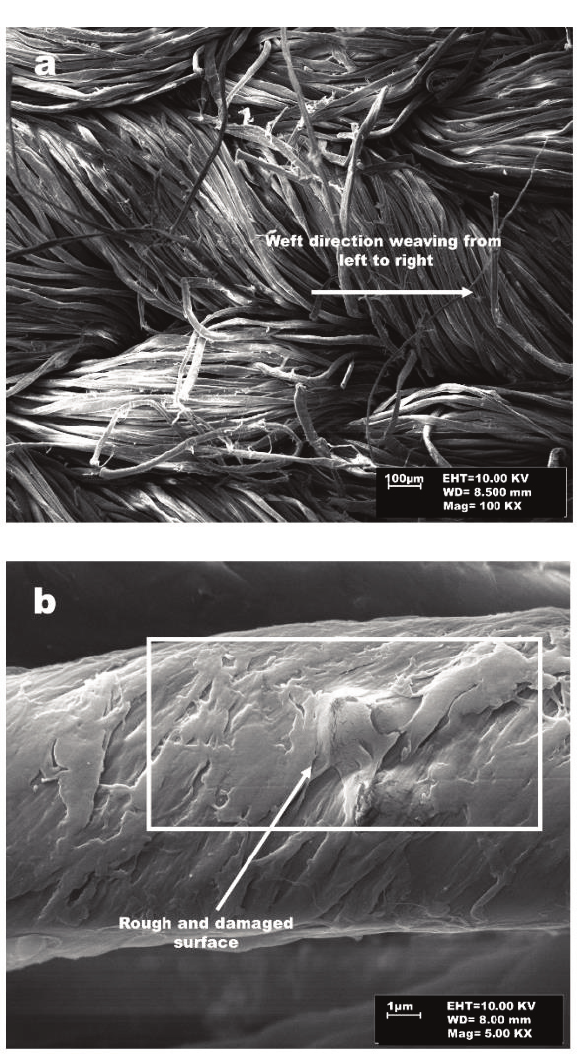
Fig. 3. (a) SEM image of weft direction woven from left to right, (b) surface damage at higher